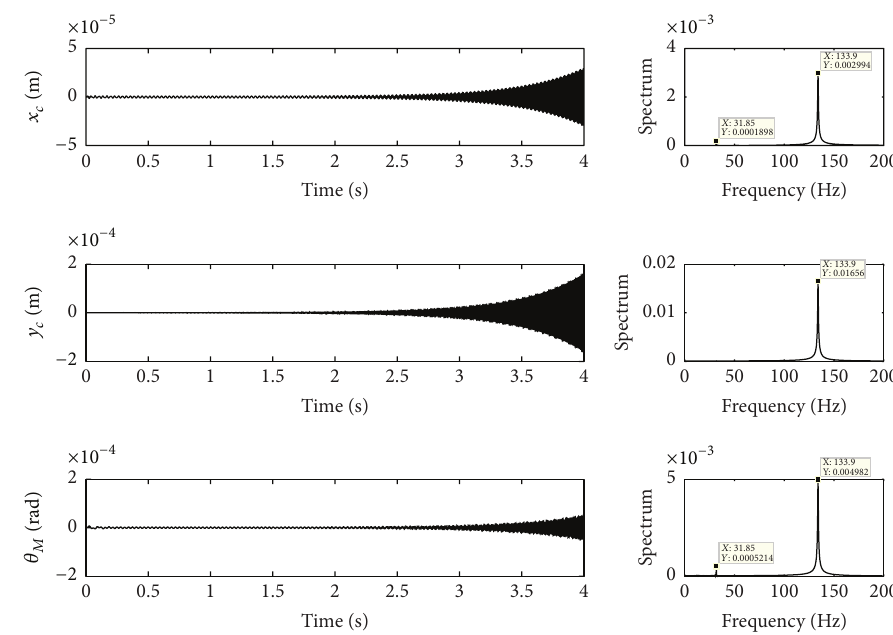
Figure 11: Dynamic response to periodic disturbance of strip entry thickness for V 𝑟 = 21